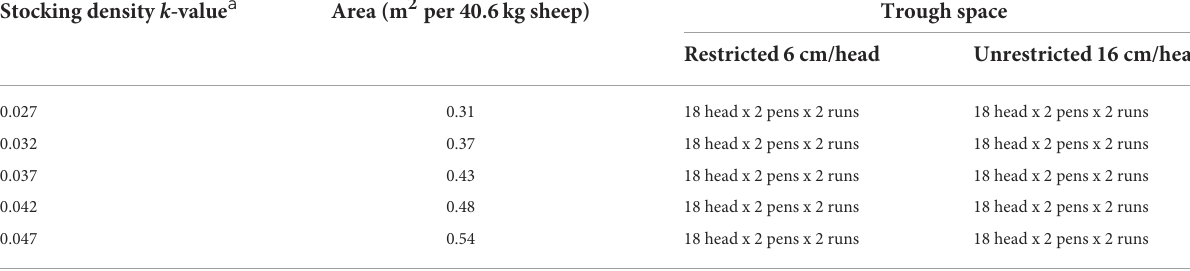
TABLE 1 Randomised block experimental design for stocking densities and trough space restriction treatment groups. Stocking density k- value